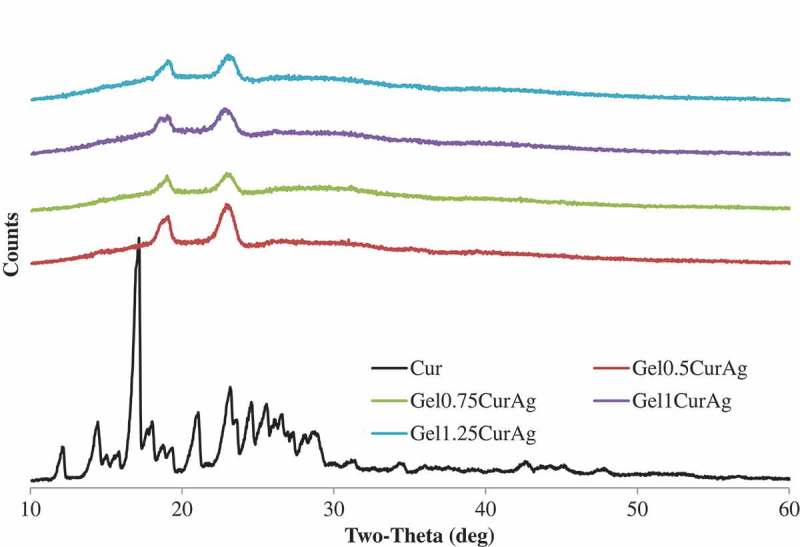
X-ray diffraction patterns of curcumin (black) and GelCurAg lyophilized powders.